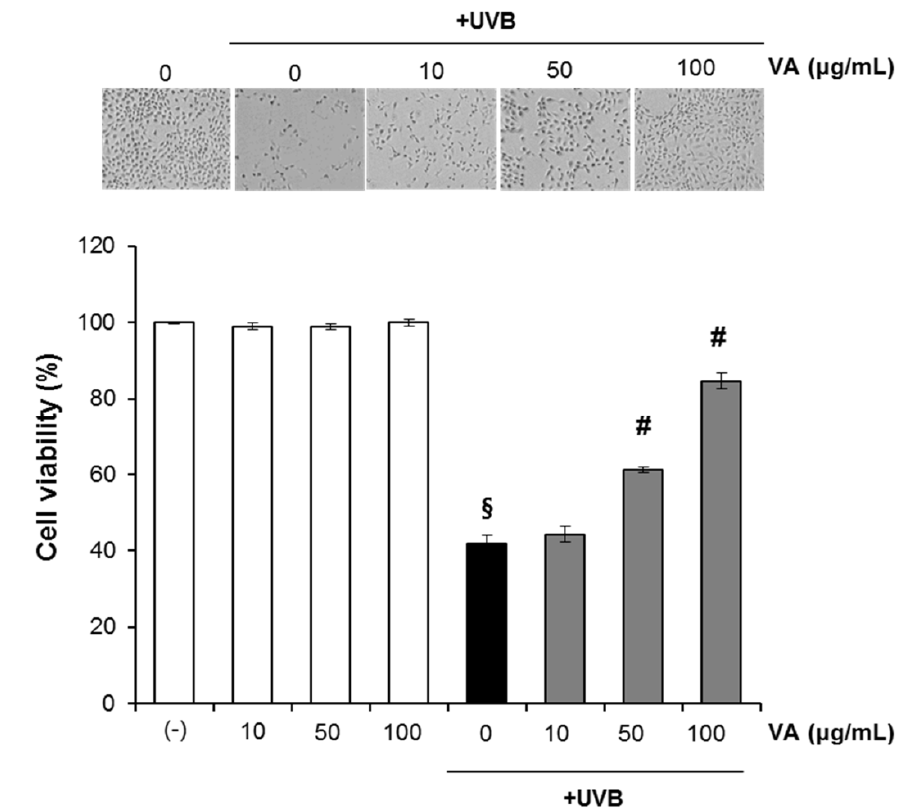
p < 0.01 compared with the vehicle-treated group; # p < 0.01 compared with the UVB treated group; (N = 5); VA: veratric